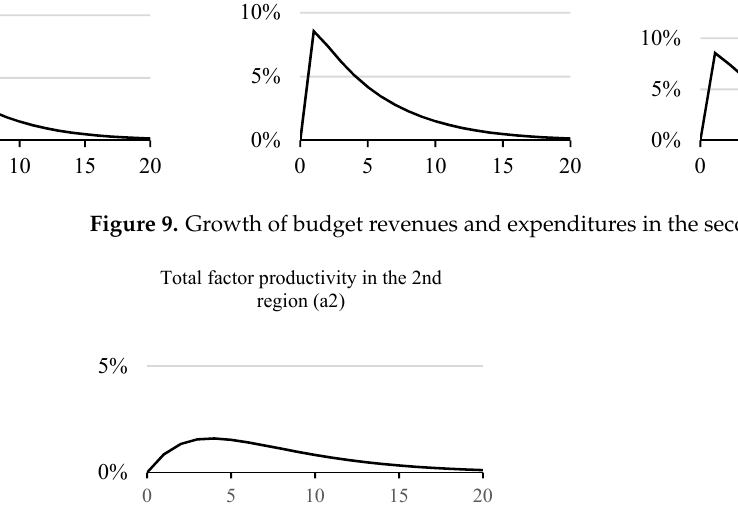
Figure 10. Growth of budget revenues and expenditures in the second region. In the labor market (Figure 11), there is simultaneously an increase in the demand for labor against the background of the expansion of production and an increase in the supply of labor due to an increase in healthcare costs. The second effect outweighs the first; as a result, wages are reduced. Consumption is declining as a result of a reduction in wages and an increase in the interest rate (see below).